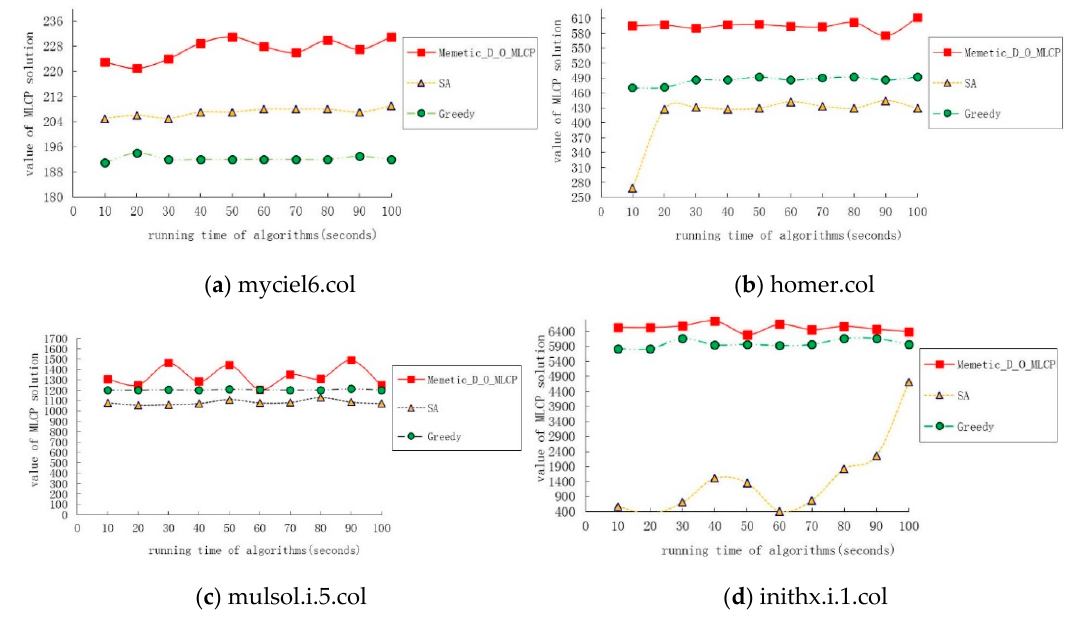
Figure 5. Running curves of the Memetic_D_O_MLCP, SA and Greedy on benchmark instances.